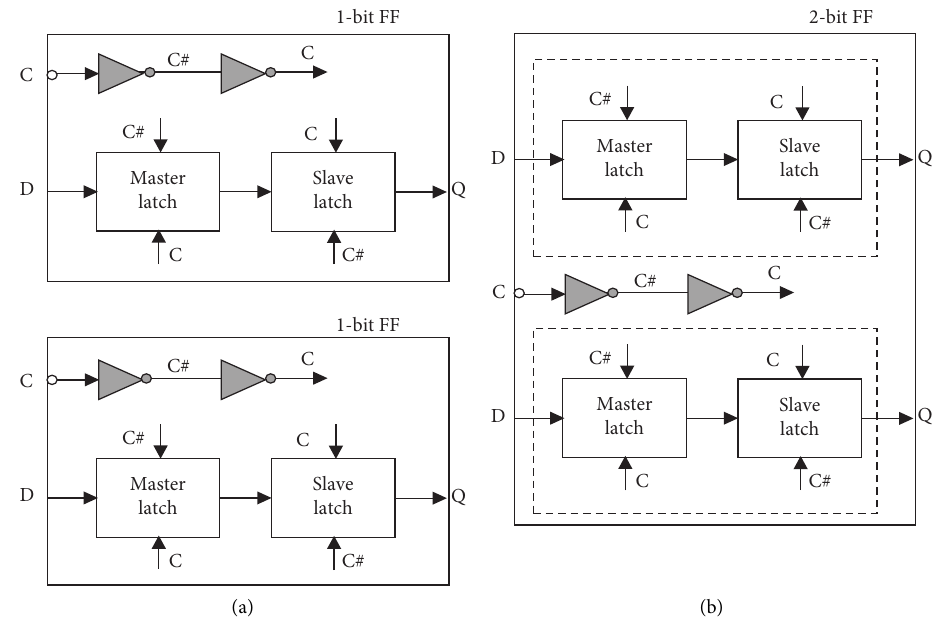
Figure 6: Merging two 1-bit flip-flops into one 2-bit flip-flop. (a) Before merging. (b) After merging.